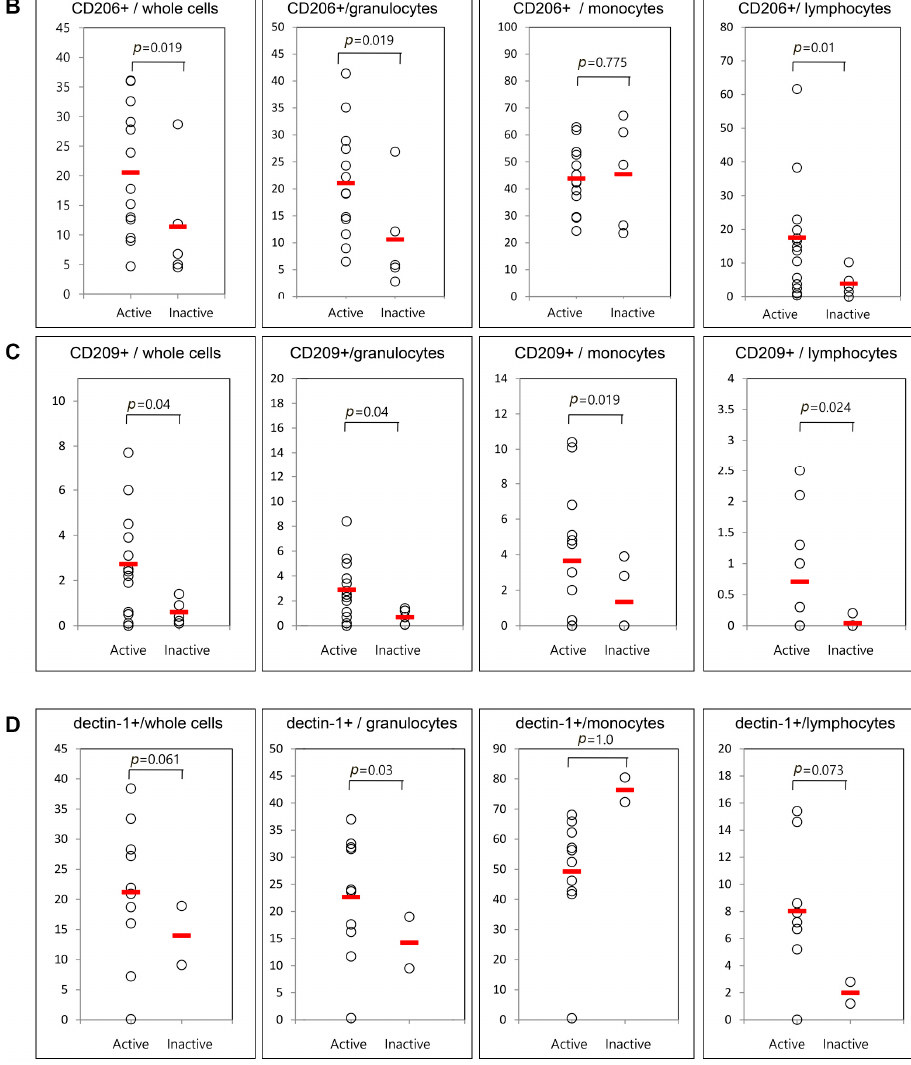
Figure 4. Flow cytometric results of the percentage of surface-stained cells presenting CD32 ( A ); CD206 ( B ); CD209 ( C ); and dectin-1 ( D ) according to disease activity in patients with AOSD. The results were obtained from 18 samples from AOSD patients. Thirteen active, untreated AOSD patients were included, and follow-up samples were collected from five patients after their disease activity resolved. The horizontal line indicates the mean value for each group. The p -value was determined with the Mann–Whitney U -test.